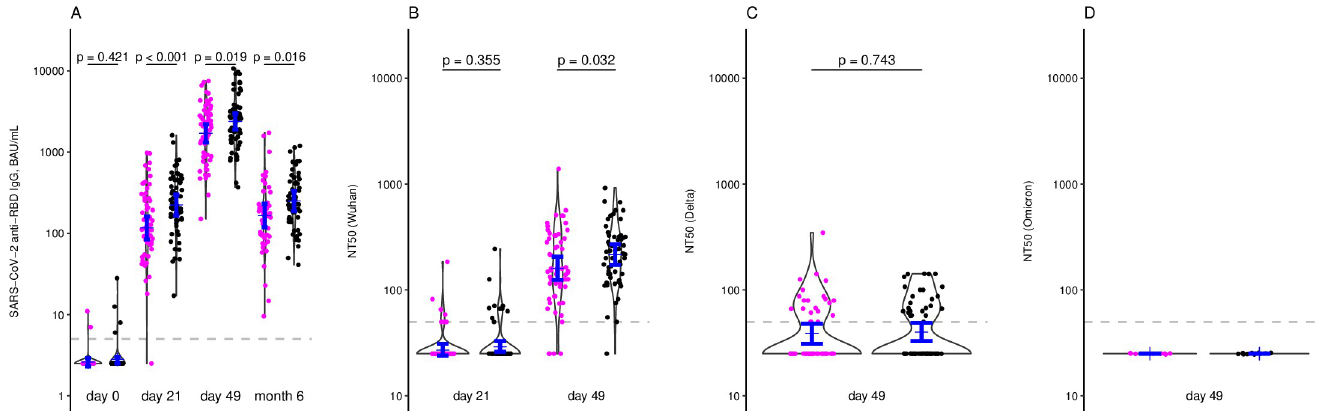
Fig 4. Kinetics of immune responses per study arm of the per-protocol cohort. SARS-CoV-2 anti-RBD IgG binding antibody data are shown on days 0/21/49 and month 6 post first dose (A), SARS-CoV-2 Wuhan neutralizing antibodies on days 21/49 (B) and SARS-CoV-2 Delta (C) and Omicron (D) neutralizing antibodies on day 49 per study arm (purple = 20 μ g, black = 30 μ g). In the case of SARS-CoV-2 anti-RBD IgG binding antibody at month 6, five samples were excluded due to a detected breakthrough infection before month 6. Blue bars indicate geometric mean titres with 95% CI. NT50 = 50% neutralizing antibody titre, RBD = SARS-CoV-2 receptor binding domain, BAU = binding antibody